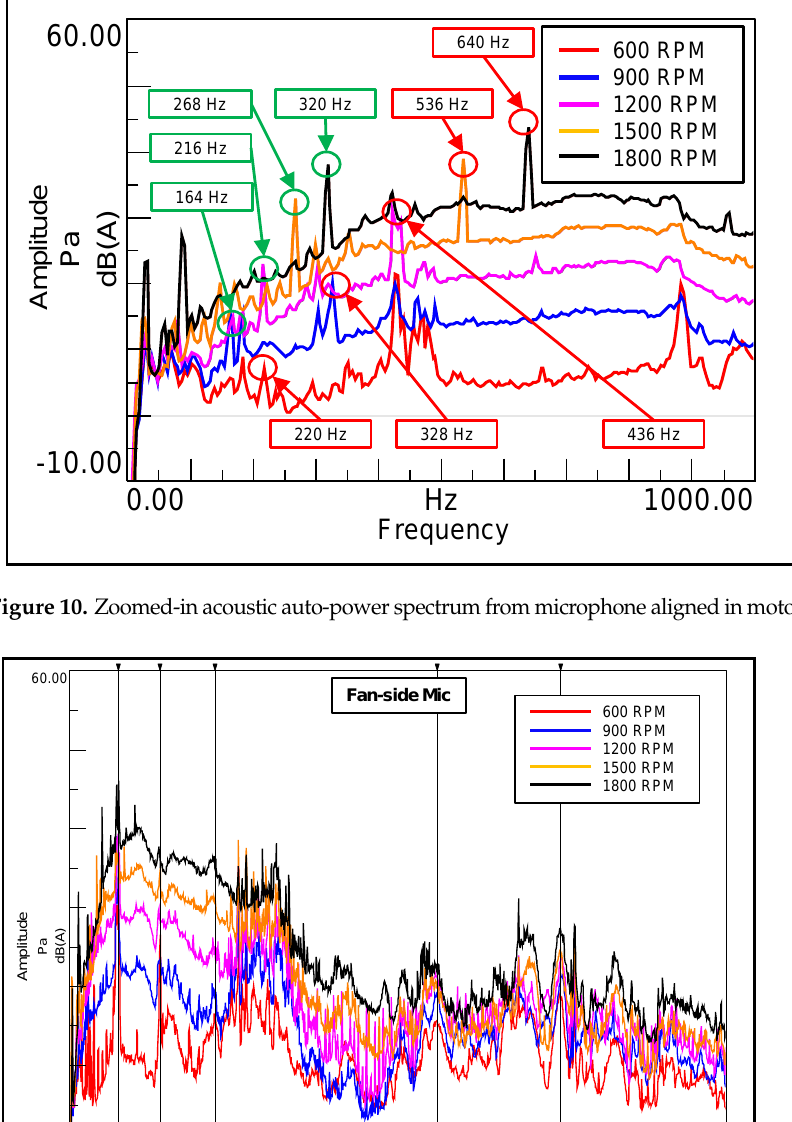
Figure 9. Acoustic auto-power spectrum from a microphone aligned in motor ’ s radial direction with RMS dB(A) values at 600, 900, 1200, 1500, and 1800 rpm.